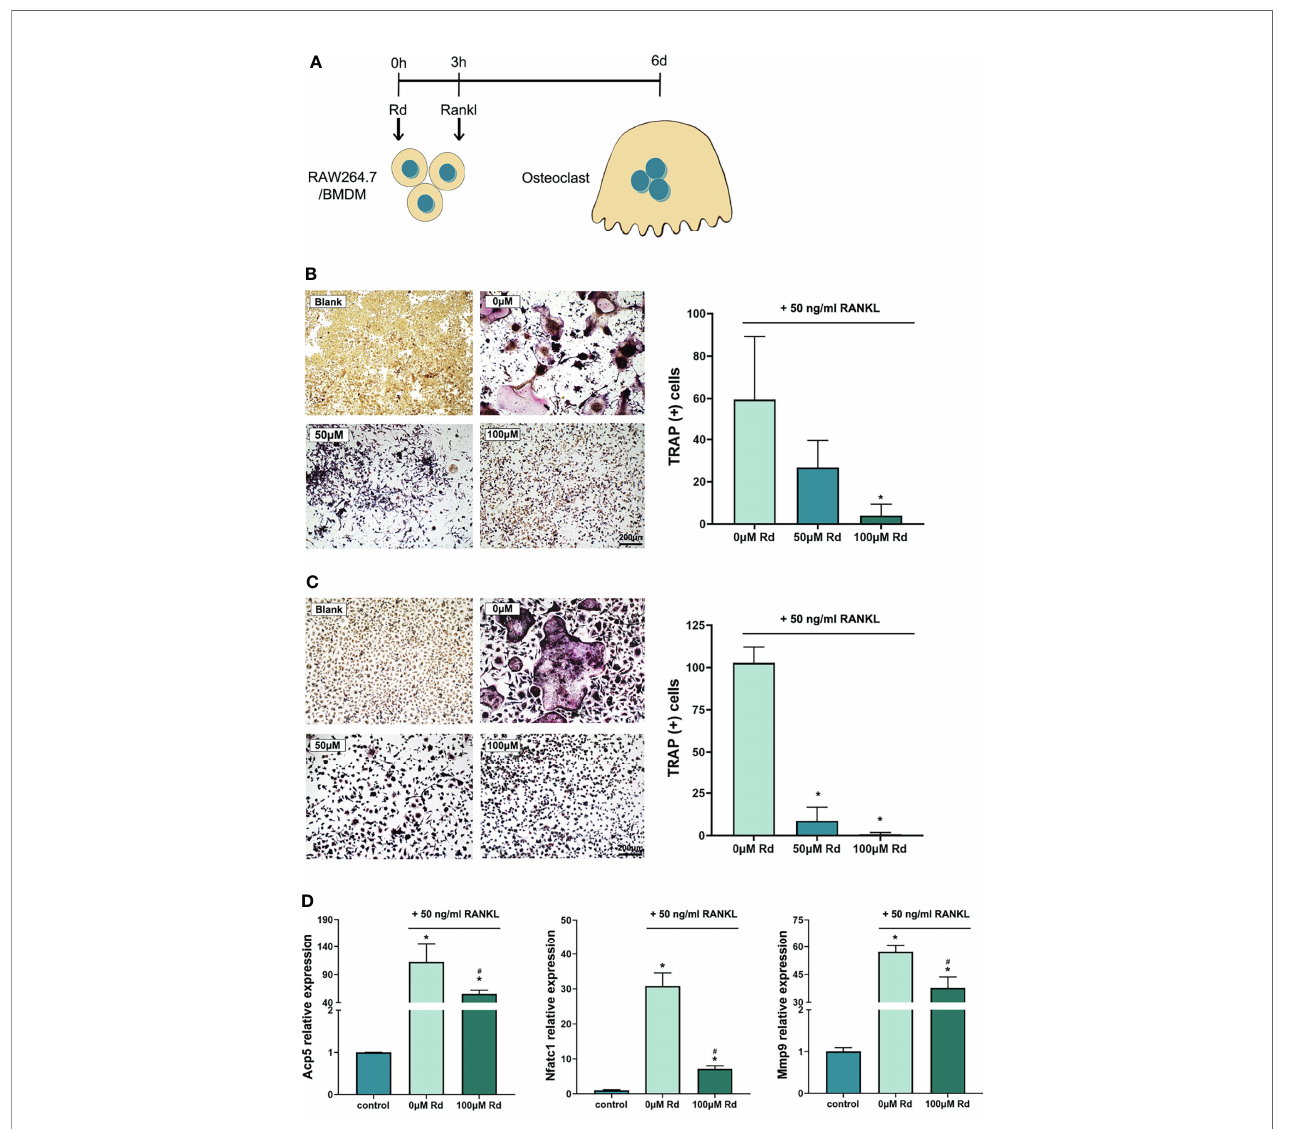
FIGURE 4 | Inhibitory effects of ginsenoside Rd on osteoclastogenesis in vitro . (A) The sketch of antiosteoclastogenesis experiments in vitro . Photographs of multinucleated TRAP (+) cells differentiated from (B) RAW264.7 cells and (C) BMDMs were taken under ×10 magni fi cation, and multinucleated cell amounts were counted. The results are shown as mean ± SD ( n = 3). (D) Expression of osteoclast marker genes. The results were normalized by the 2 − DD Ct method relative to the mice GAPDH reference gene and shown as mean ± SD ( n = 3). * p < 0.05 versus the normal control; # p < 0.05 versus the 0- m M